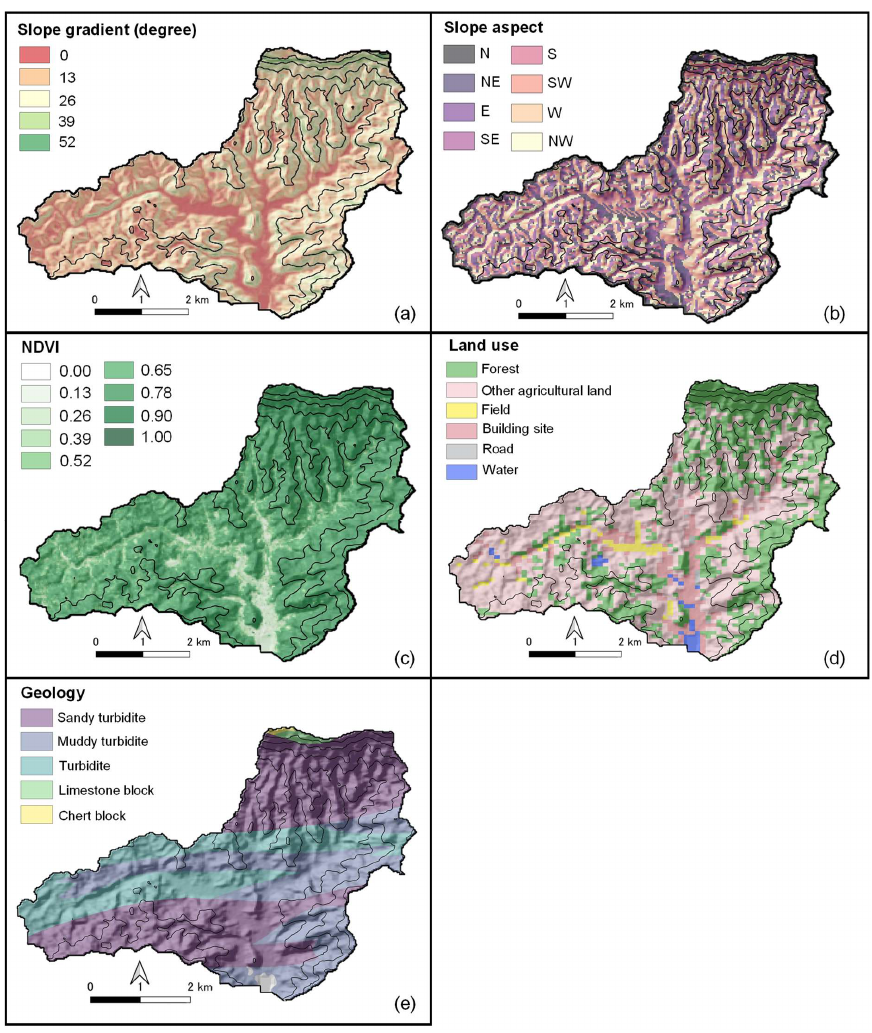
Figure 3. The distributions of the landslide conditioning factors: ( a ) slope gradient, ( b ) slope aspect, ( c ) normalized difference vegetation index, ( d ) land use, and ( e ) geology. The solid lines in the maps indicate contour lines with an interval of 100 m.